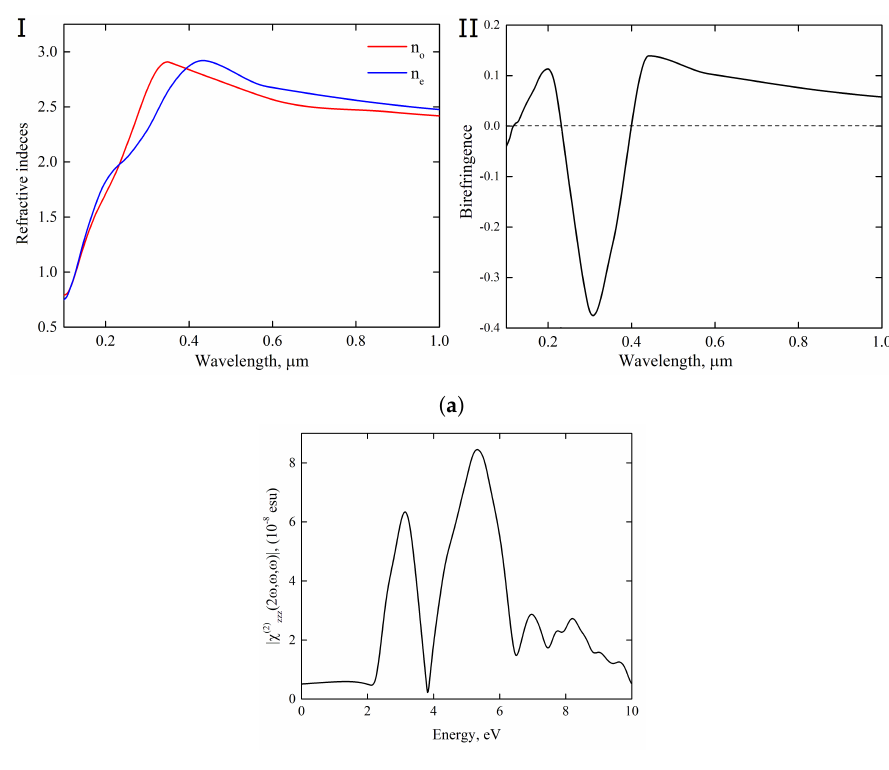
Figure 8. Optical responses: ( a ) The phenomena of anomalous dispersion of refractive indicies (I) and of anomalous birefringence ( ∆ n = n e − n o ) (II) in uniaxial Y 2 H 3 O(OH). The optic axis is fixed in the z direction. In subsection (II), crossing of the dashed line with the birefringence curve indicates λ = 117, 231, and 401 nm as isotropic points in the given spectral region. ( b ) Prediction of the second-harmonic generation (SHG) spectrum of Y 2 H 3 O(OH) represented in terms of the spectral behavior of the absolute value of the second-order susceptibility tensor component χ zzz ( 2 ω , ω , ω )